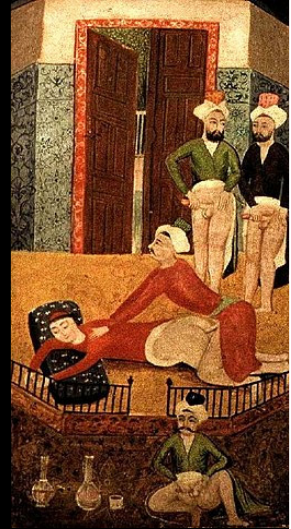
Figure 3. The Ottoman Turkish illustration depicting a young man used for group sex (from Sawaqub al-Manaquib); 19th century. Source: Murray (2000, p. 135), Homosexualities, University of Chicago Press, ISBN 978-0-226-55194-4.